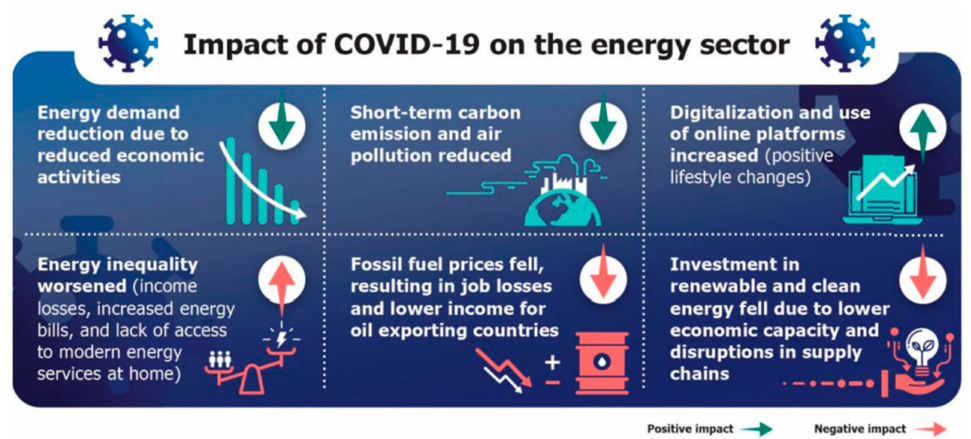
Figure 1. Key impacts of the pandemic on the energy sector